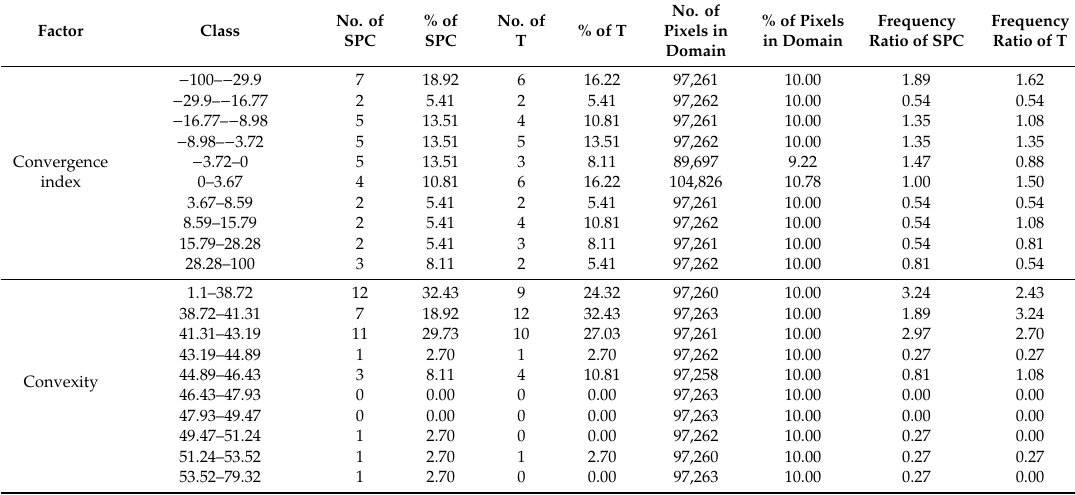
Table A1. Results of the frequency ratio